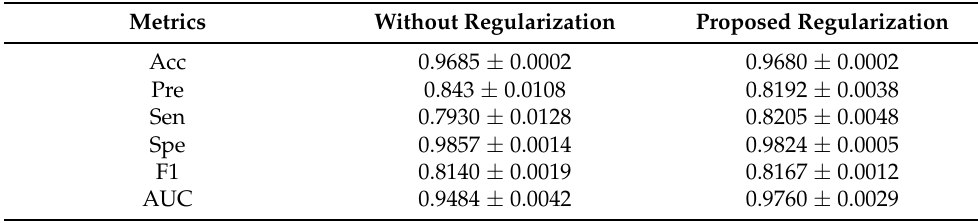
Table 2. Results of DRIVE with and without